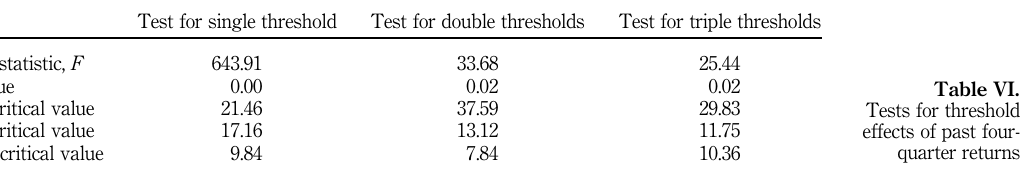
Table VI. Tests for